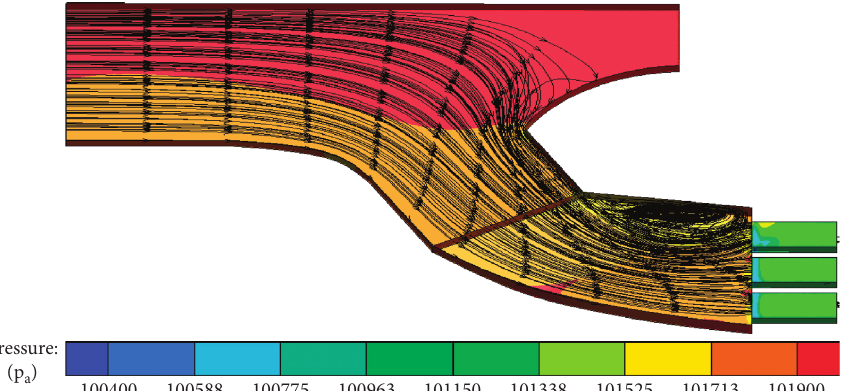
Figure 9: 3D flow field diagram of the lateral 60 ° bending angle